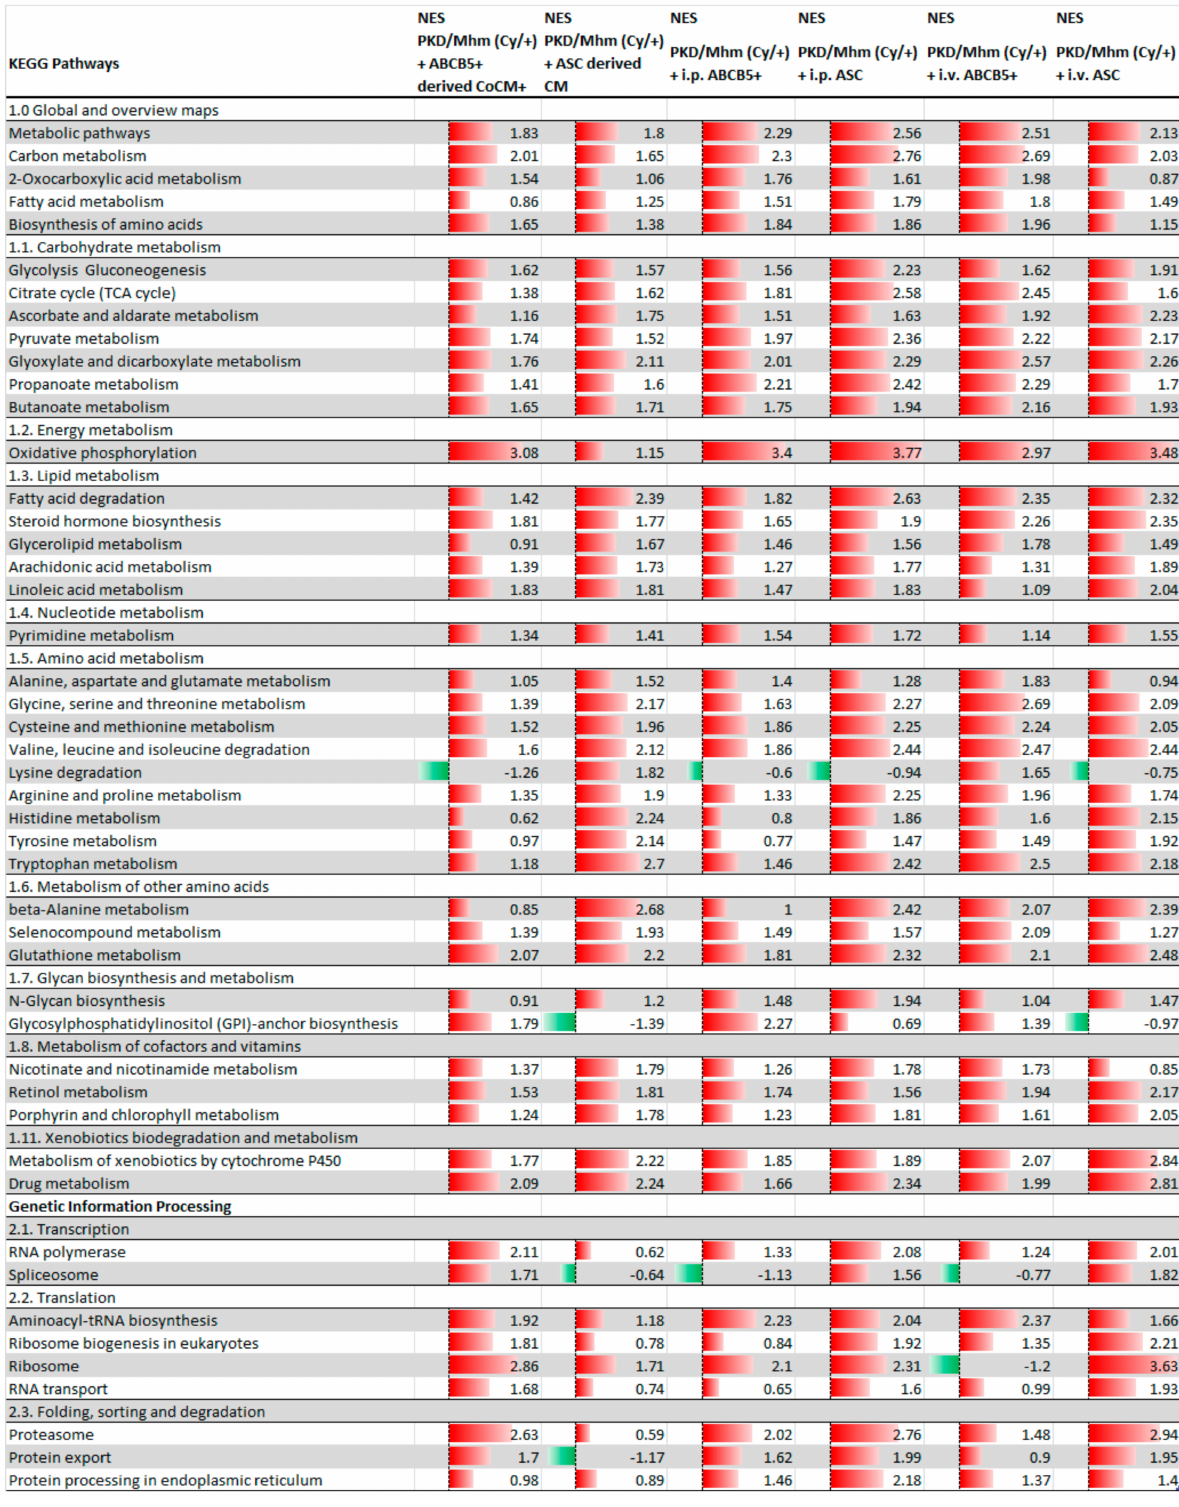
Figure 1. GSEA analysis using KEGG database. Principal upregulated pathways in i.v. ABCB5 + ; i.p. ABCB5 + ; ABCB5 + − derived CoCM + ; i.v. ASC groups; i.p. ASC and ASC − derived CM groups. Significantly ( adj. p < 0.05) differentially expressed pathways (PKD/Mhm (Cy/+) + treatment vs. PKD/Mhm (Cy/+)). Data are sorted by main categories. Normalized enrichment score (NES) is given for each